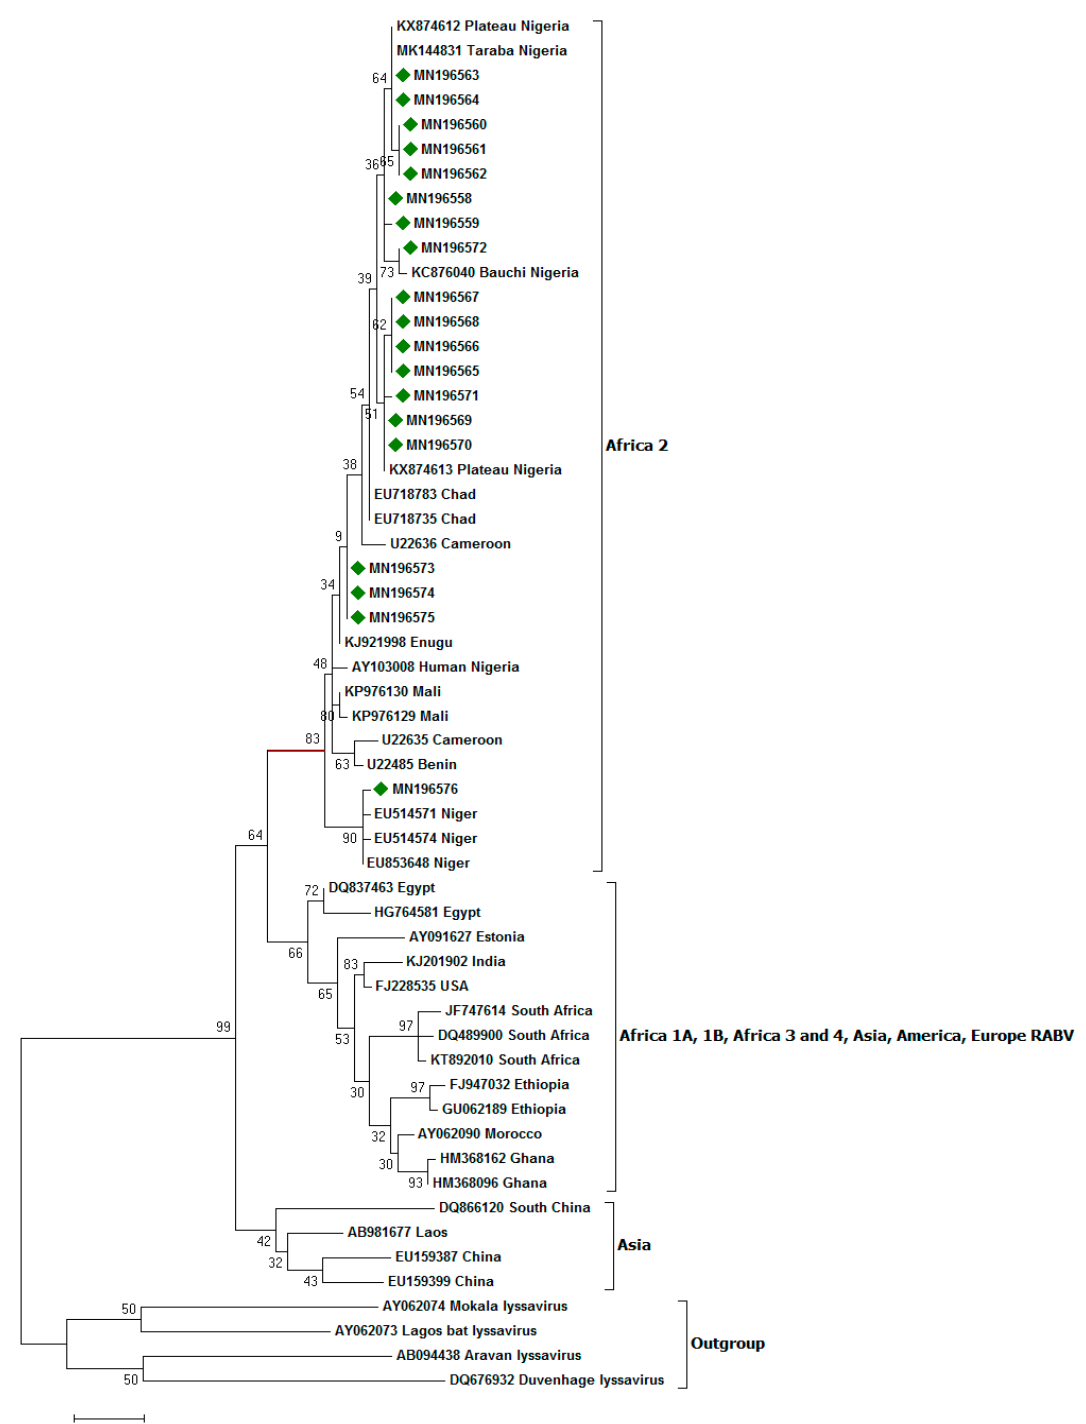
Figure 2. Maximum likelihood (ML) phylogenetic tree of the 19 Southeastern Nigerian RABV N-genes generated using ML algorithm (1000 bootstrap replications). The analyses involved 56 nucleotide sequences. All positions with <95% site coverage were eliminated. Evolutionary analyses were conducted in MEGA7 [34]. The bootstrap values (%) are shown on the nodes supporting these branches. The tree is drawn to scale, with branch lengths in the same units as those of the evolutionary distances used to infer the phylogenetic tree. The evolutionary distances were computed using the Kimura two-parameter method [37] and are in the units of the number of base substitutions per site. Isolates for which the partial N gene sequence was obtained in this study are indicated by a diamond green color.